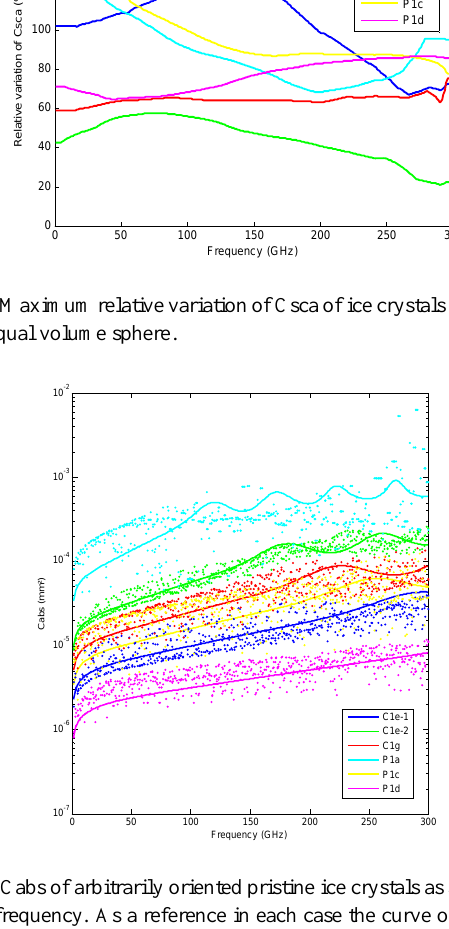
Fig. 5. Relative variation of Csca of ice crystals (averaged orientation) compared to an equal volume sphere.